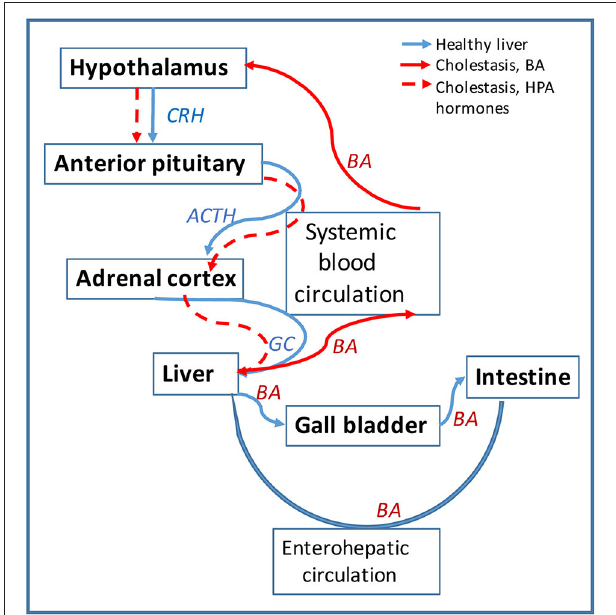
FIGURE 3 | Bile acids (BA) affect the HPA axis function in hepatic cholestasis. Diagram showing the circulation of signaling hormones of HPA axis (CRH, ACTH and GC) and of BA produced in the liver is shown in blue arrows. Circulation of the same molecules is represented in red arrows for hepatic cholestasis. In healthy liver, BA are synthesized from cholesterol in hepatocytes and secreted via cholangiocytes into the gall bladder and then into intestine; most of BA is recycled from the intestine back into the liver via the enterohepatic circulation. In cholestatic liver, BA are not transported into the gall bladder but retained into the liver. BA escape into systemic circulation and cause leakage of blood brain barrier (BBB) getting entrance into the brain. In the hypothalamus, BA downregulate CHR and repress the HPA axis activity. The lack of GC in the liver alters BA homeostasis, causing BA to flood more into the systemic